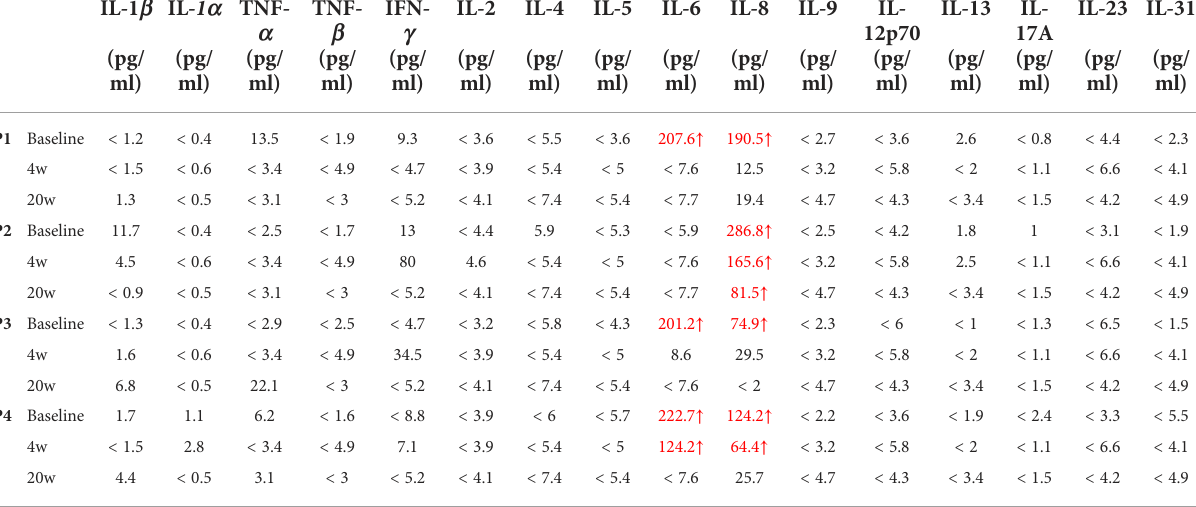
TABLE 2 Serum cytokine changes after 20 weeks of dupilumab